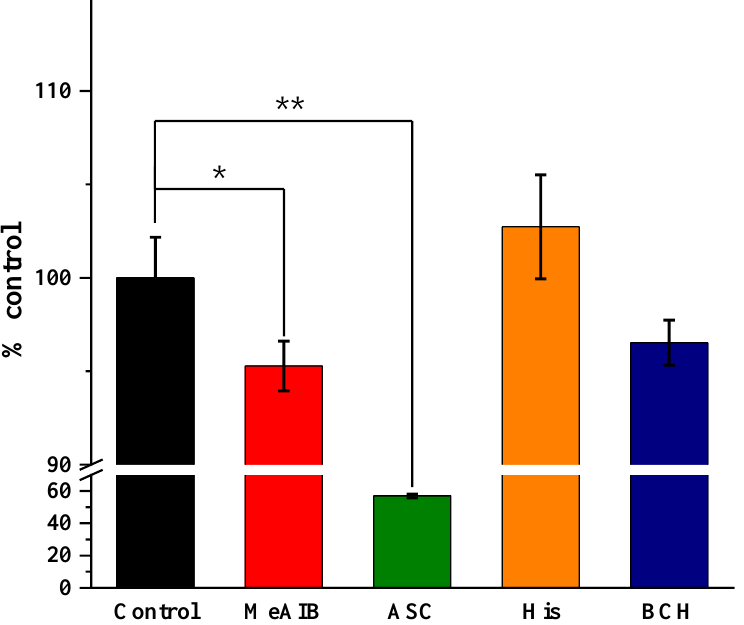
Figure 3. In vitro cellular uptake inhibition results of [ 99m Tc]TcO-MOPADTC conducted in S180 cells, incubation 20 min (* p < 0.05, ** p < 0.01).